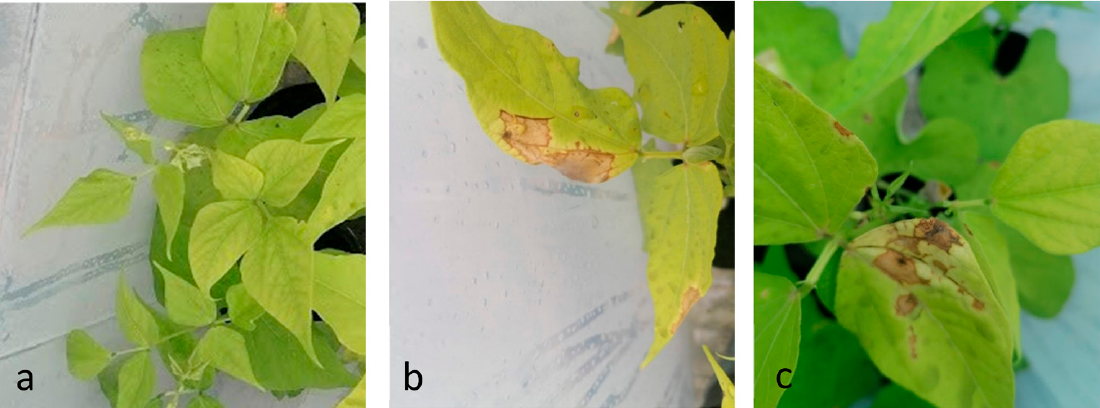
Figure 2. Common bean plants inoculated with A. arundinis CREA OF 1128.1: ( a ) non-inoculated control; ( b , c ) details of lesions on common bean leaves infected with A. arundinis CREA OF 1128.1.